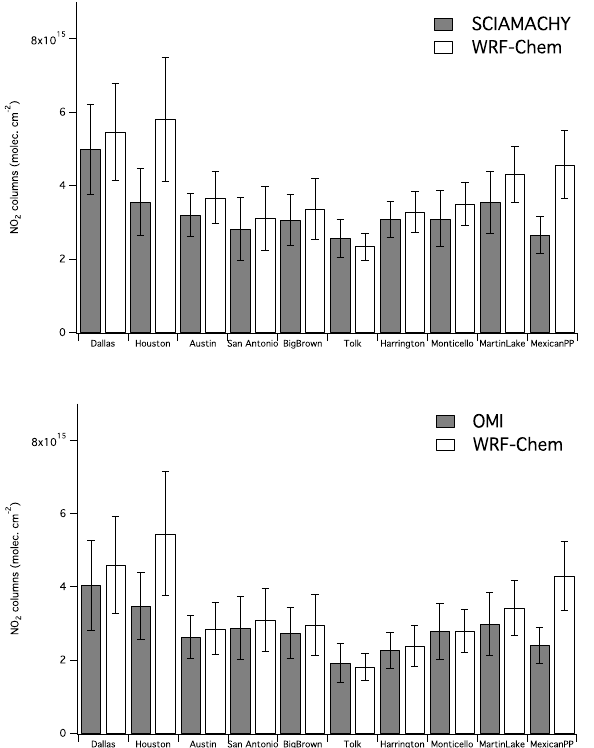
Fig. 5. Comparison of satellite and model tropospheric NO 2 col- Figure 5. Comparison of satellite and model tropospheric NO 2 column for various source boxes: 3 umn for various source boxes: (top) U. of Bremen SCIAMACHY (top) U. of Bremen SCIAMACHY and (bottom) averages of 4 OMI retrievals. The four OMI 4 and (bottom) averages of 4 OMI retrievals. The four OMI retrievals retrievals are produced by KNMI, NASA, and the University of Bremen. Temporal variability 5 are produced by KNMI, NASA, and the University of Bremen. (standard deviation) of columns is shown as error bars. The data for July 26, 2006 – October 6, 6 Temporal variability (standard deviation) of columns is shown as error bars. The data for 26 July 2006–6 October 2006 are used. For 2006 are used. 7 SCIAMACHY (OMI), the numbers of samples are 12(18), 4(14), 11(16), 5(16), 10(16), 9(22), 6(17), 6(21), 14(22), and 4(14) days for Dallas, Houston, Austin, San Antonio, Big Brown and Lime- stone, Tolk, Harrington, Monticello and Welsh, Martin Lake, and a Mexican power plant, respectively.